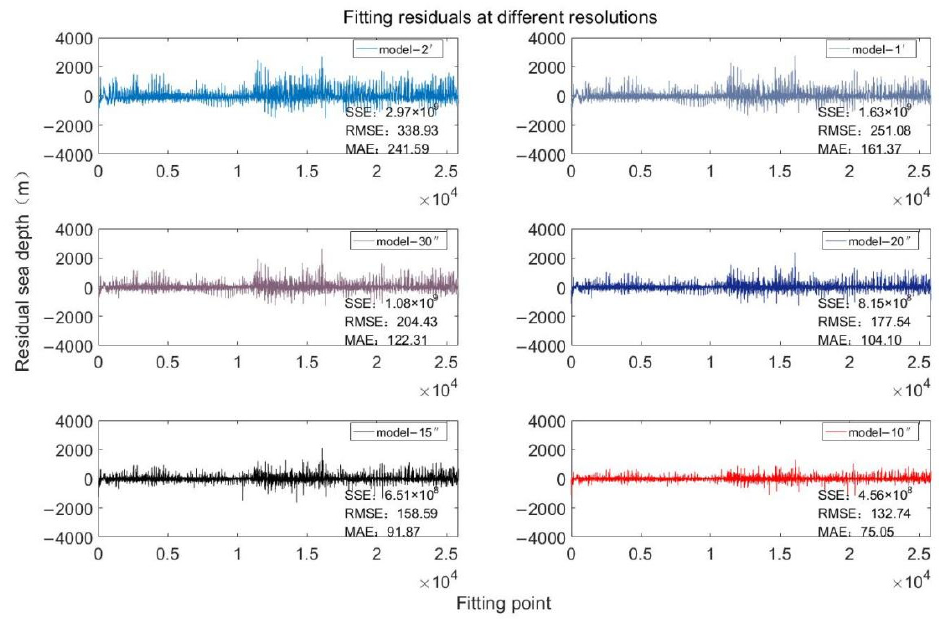
Figure 4. The residual distribution at different resolution inversion topographies.